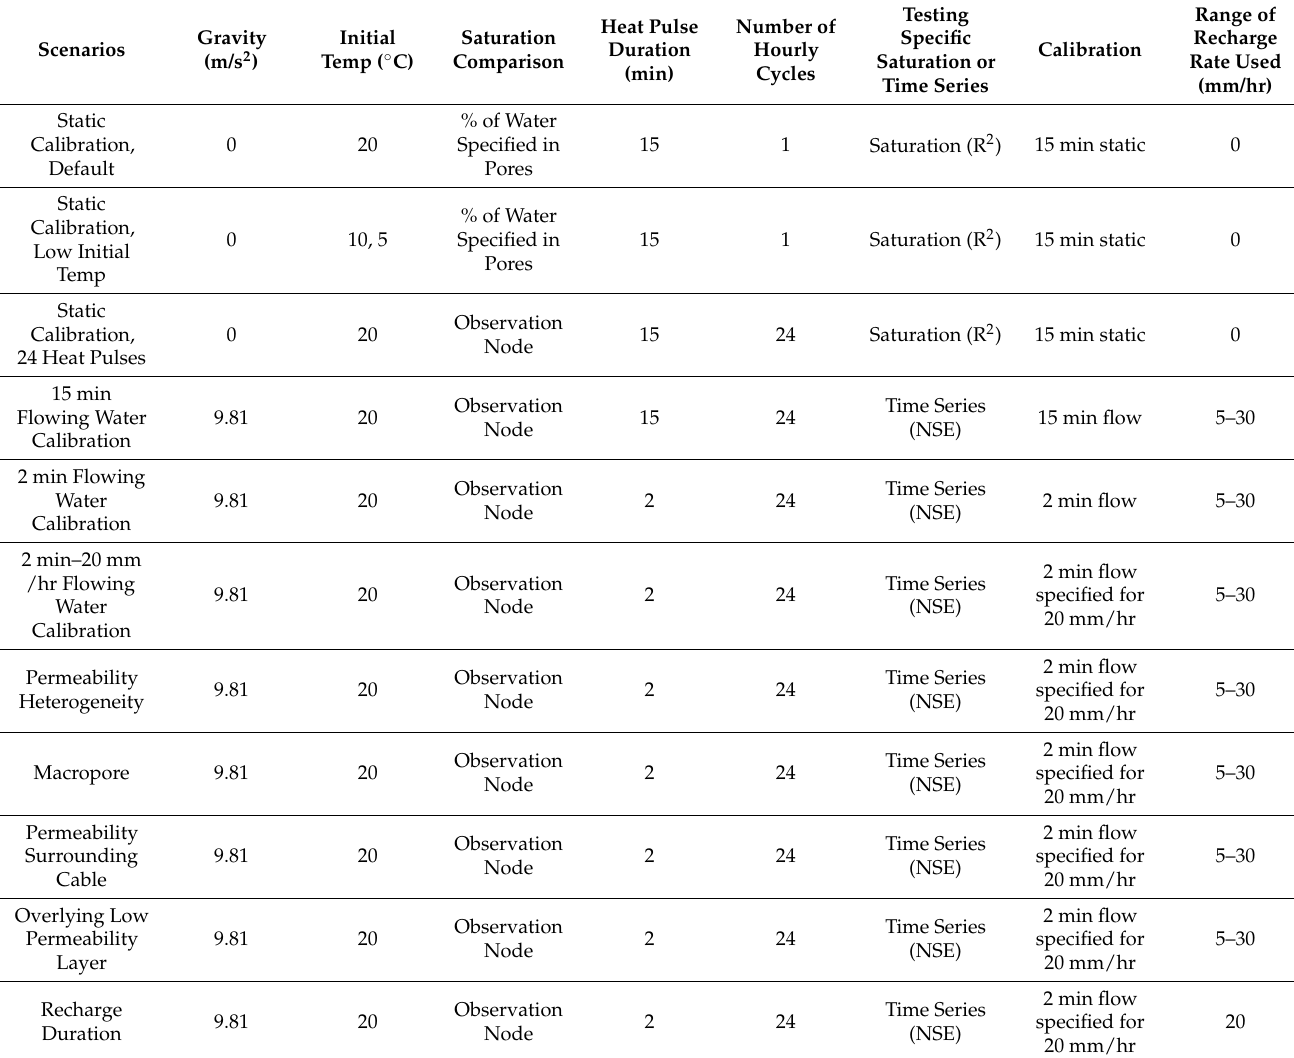
Table 2. Summary of